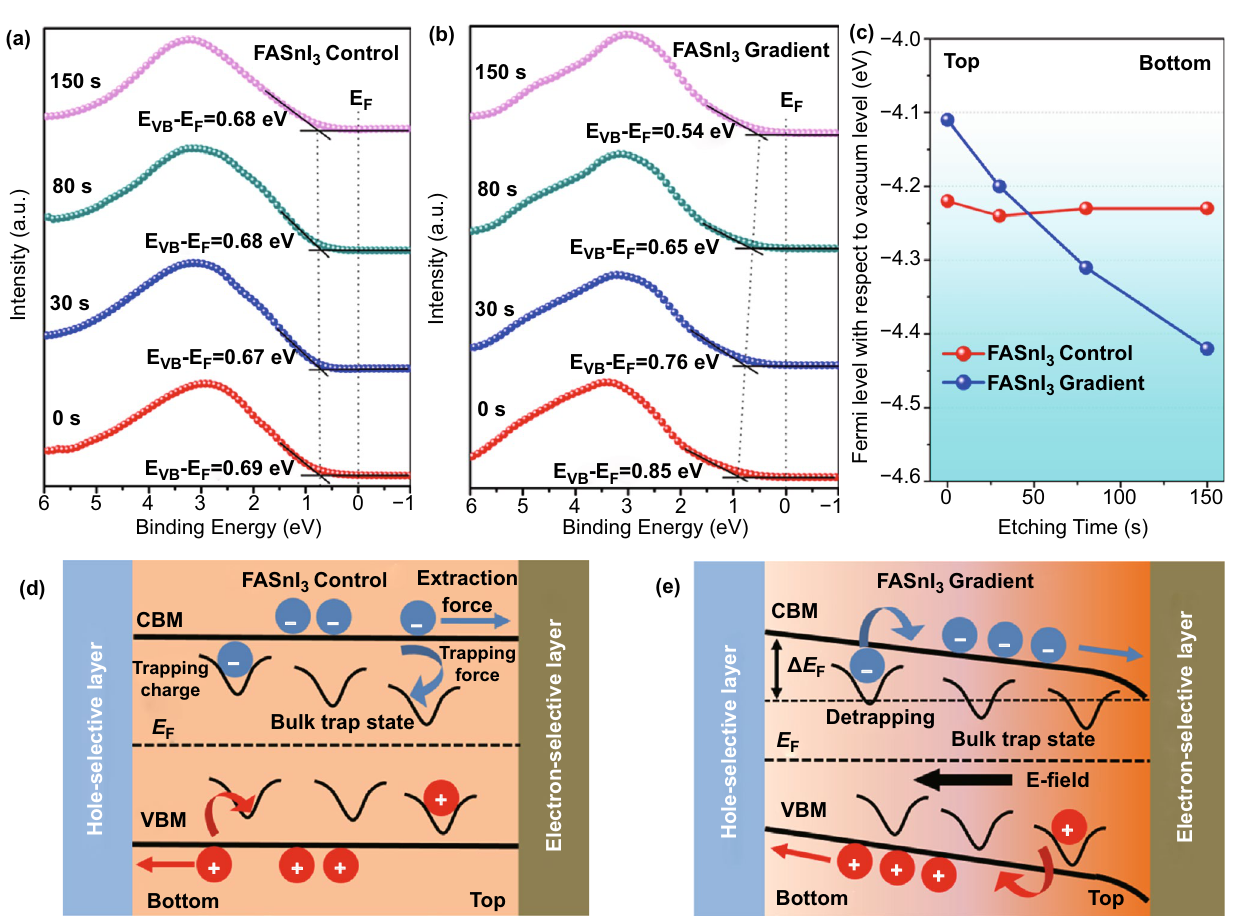
Fig. 3 The valence-band XPS spectra of the a FASnI 3 control and b FASnI 3 gradient films with different Ar + etching time. c Depth profiles of the E F in FASnI 3 control and FASnI 3 gradient films derived from the valence-band XPS analysis. Predicted energy-level diagram and charge trapping model in the d FASnI 3 control and e FASnI 3 gradient films in contact with the electron-selective and hole-selective